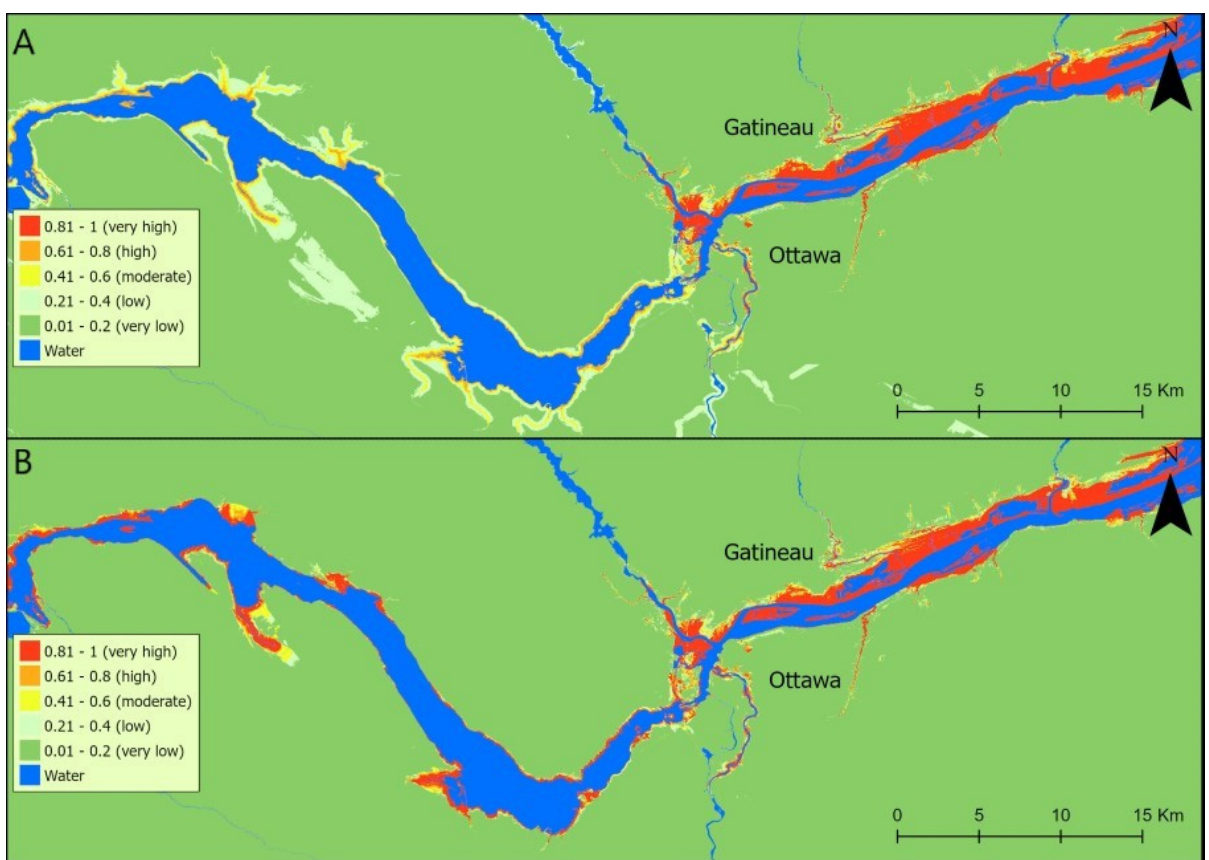
Figure 5. Flood susceptibility maps from the random forest classification model predictions: ( A ) based on single site training; and ( B ) based on multi-sites training.